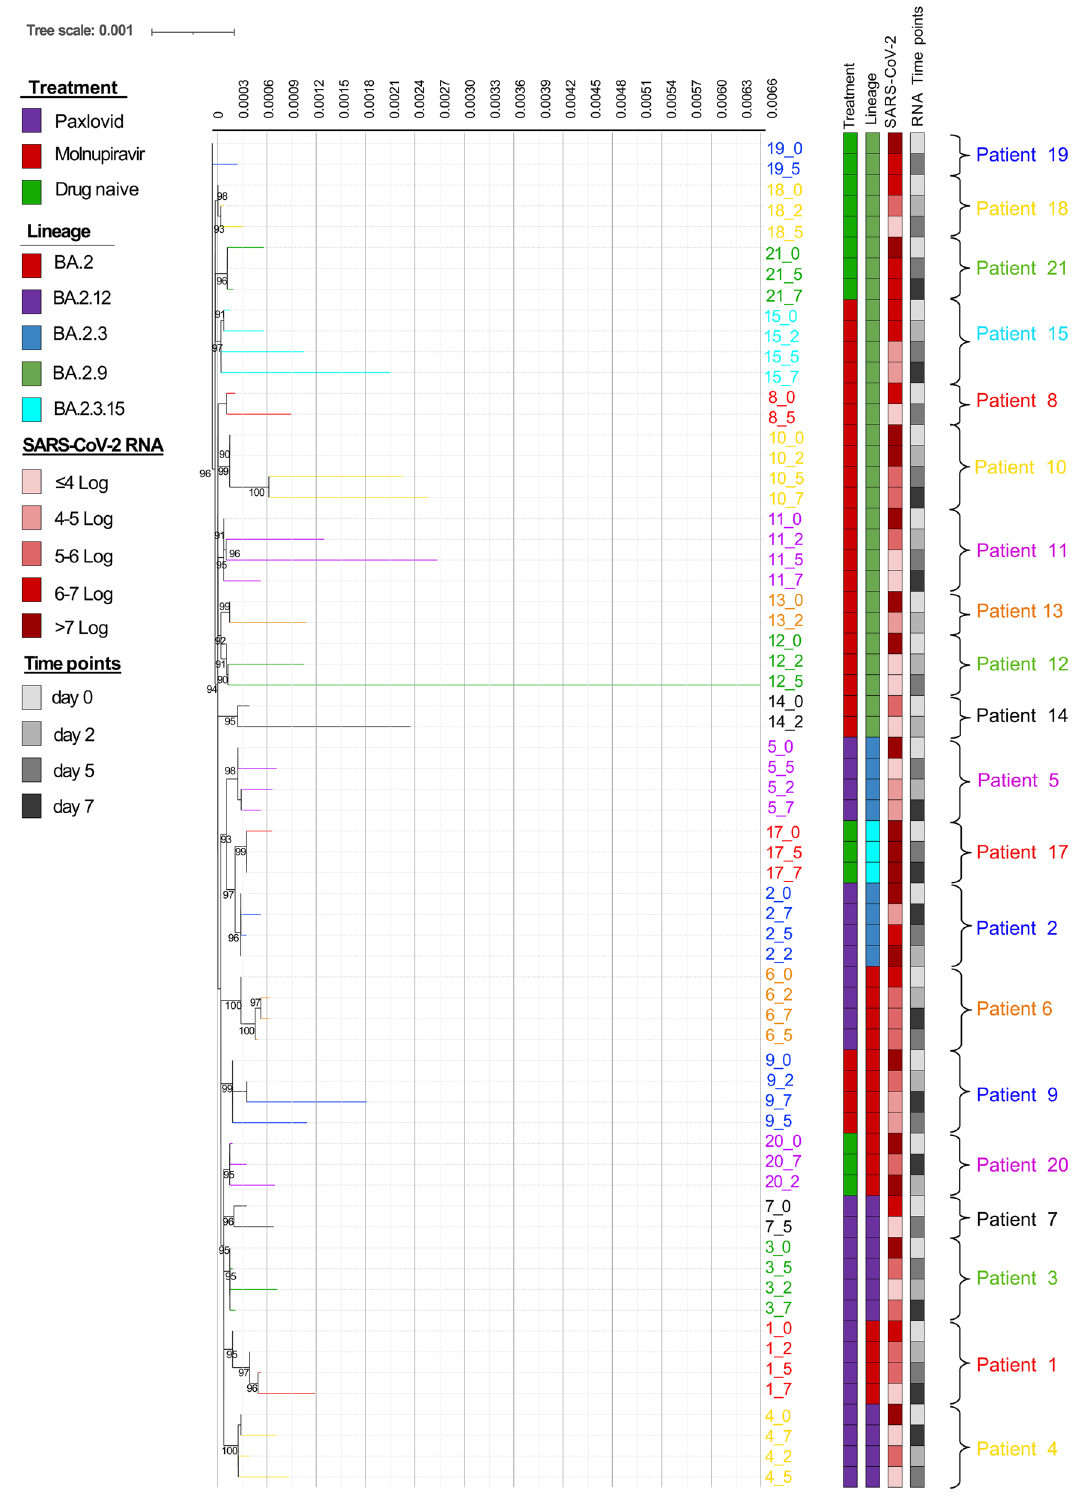
Fig. 2 Estimated maximum likelihood phylogenetic tree of the SARS-CoV-2 strains from Molnupiravir-treated, Paxlovid-treated and drug naïve individuals. The phylogeny was estimated with IqTree2 using the best- fi t model of nucleotide substitution TN + F + G4 with 1000 replicates fast bootstrapping. Leaves number represents the sample ID, bootstrap values higher than 90 are shown on branches, color of branches represents the different patients whose ID is also reported next to the tree with brackets. Information regarding treatment, lineage, SARS-CoV-2 viral load and the time points analyzed were reported in the annotation columns in the right-hand side of the fi gure. Tree scale is expressed as nucleotide substitutions per